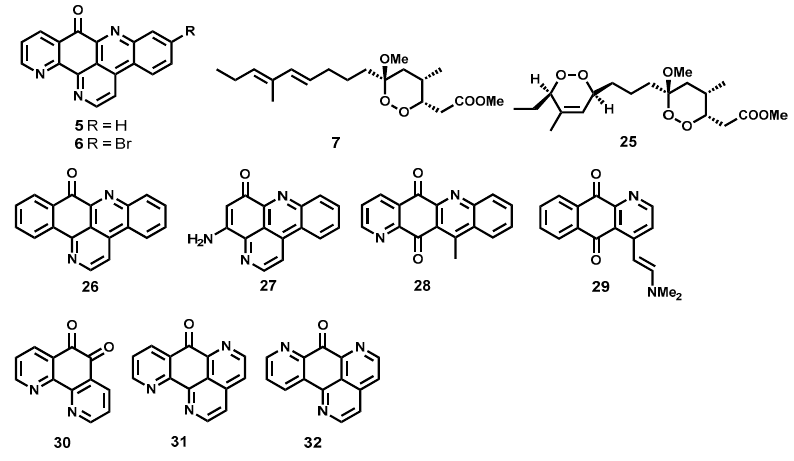
Figure 5. Trypanocidal semisynthetic compounds based on natural product scaffolds.